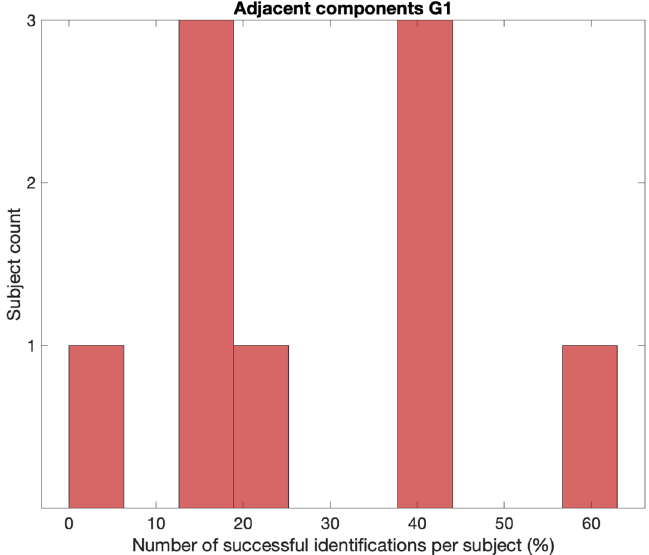
Figure 4. Disproportionate representation in subjects’ successful identification of MUs suggests subject-specific dependency. Successful identification of MUs varied between subjects (0–63% of the measurements per subject). If there would not exist a subject dependency in identifying MUs, the successful identification of MUs should have a small variation around a particular percentage.